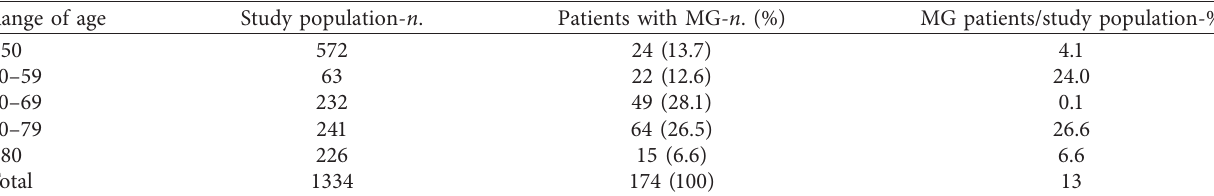
Table 2: Range of age in patients with monoclonal gammopathy.